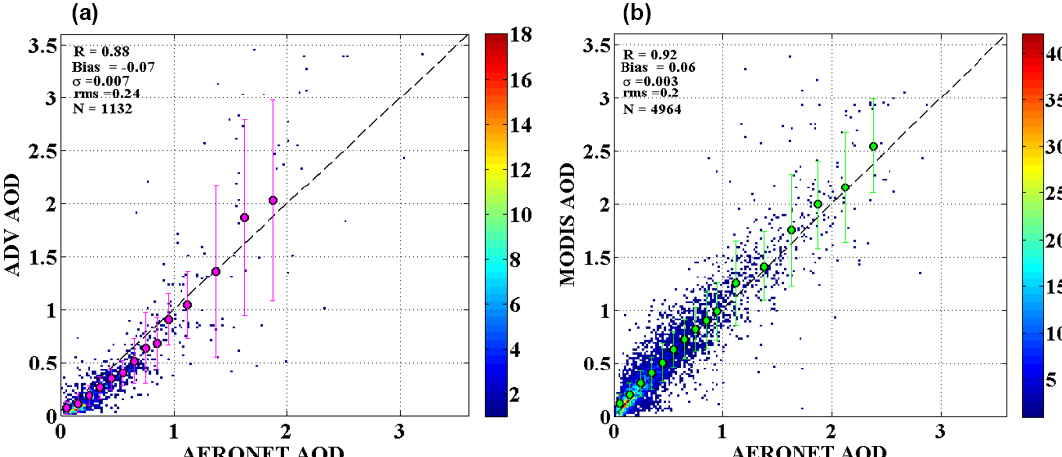
Figure 7. Density scatterplot of ATSR ADV v2.31 AOD ( a , reproduced from de Leeuw et al., 2018, Fig. 7), and MODIS C6.1 DTDB vs. AOD from AERONET stations in mainland China (b) for the years 2002–2011. The filled circles are the averaged ATSR AOD binned in 0.1 AERONET AOD intervals (0.25 for AERONET AOD > 1.0) and the vertical lines on each circle represent the 1 σ standard deviation of the averages. Statistics in the upper left corner indicate the correlation coefficient R , the bias, the standard deviation, the root mean square (rms) error and the number of data points ( N ). The color bar on the right indicates the number of data points. Table 2. AOD validation results (number of points ( N ), correlation coefficient ( R ), bias, standard deviation ( σ ) and root mean square (rms) error) for ADV and MODIS (MOD) obtained for different aerosol types, classified with the AOD and the Ångström exponent (AE). Aerosol type Conditions R Bias σ rms ADV MOD ADV MOD ADV MOD ADV MOD Background AOD < 0.2 0.59 0.17 0.04 Fine- AOD > 0.2, 0.85 0.89 0.24 dominated AE > 1 Coarse- AOD > 0.2, 0.85 0.88 − 0 . 11 0.22 -dominated AE <